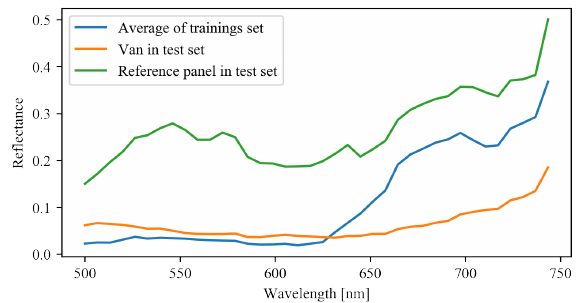
Figure 5: The mean spectra of the training dataset (forest data) and the samples from the van and the reflectance panel (nominal reflectivitity of 0.5). Image is originally from (P¨ol¨onen et al., 2020).